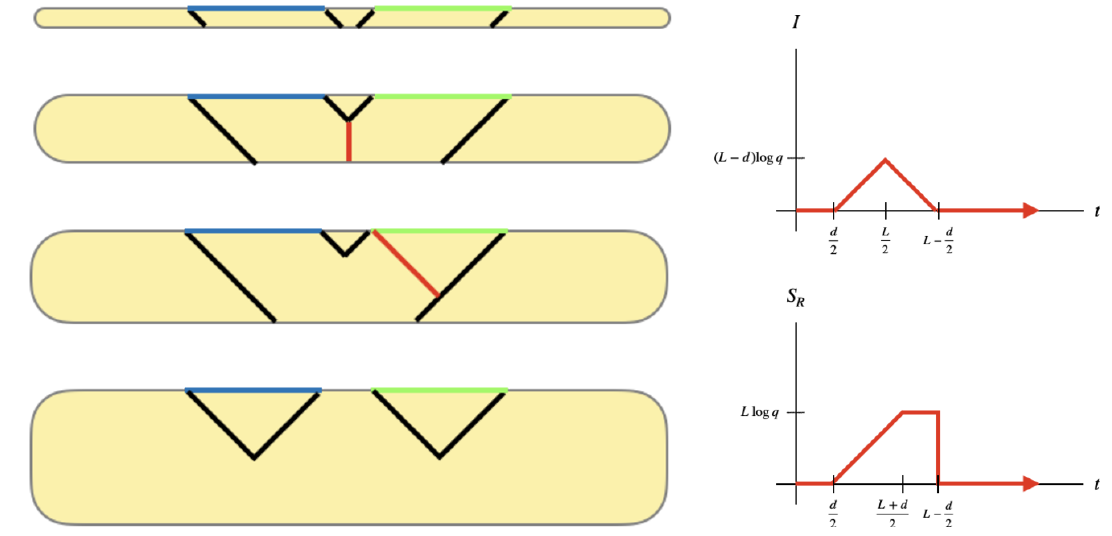
Figure 15 . The four possible con(cid:12)gurations of the minimal membranes are shown. The blue region is A , the green region is B , and time runs vertically. The black lines are membrane for the entan- glement entropy while the red line is the cross-section. At very early times, the minimal membrane is disconnected again, so the cross-section is zero. Once the membrane becomes connected, the cross-section is nontrivial and attaches to the t = 0 time slice and its area therefore grows linearly in time. At intermediate times, the cross-section connects to the minimal membrane, hence remains constant. At late times, the minimal membrane is disconnected again, so the cross-section jumps to zero. We remind the reader that the membrane con(cid:12)gurations are highly degenerate at large q so we have only displayed one particular